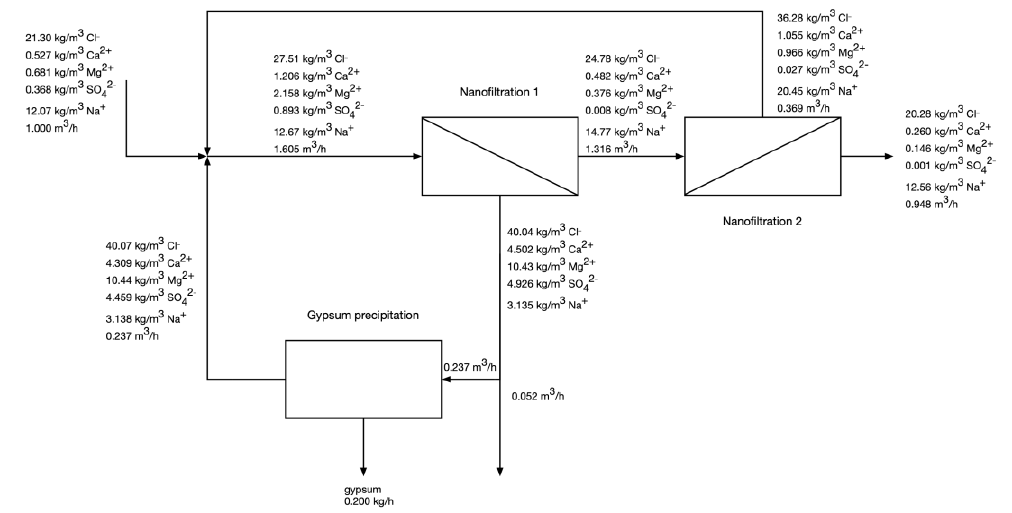
Figure 2. Calculated compositions of process streams in the two-pass NF system.